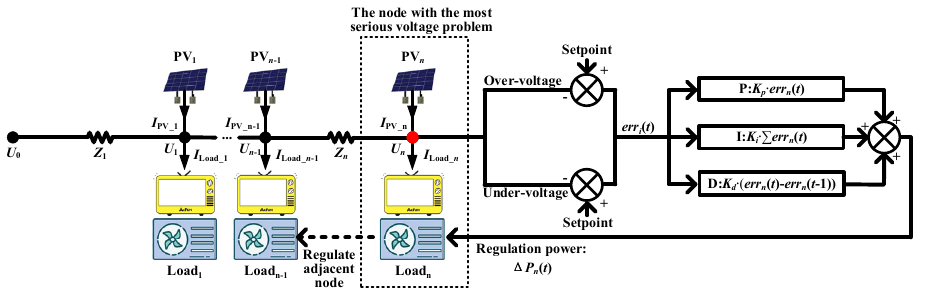
Figure 2. The distribution network model and regulation strategy.